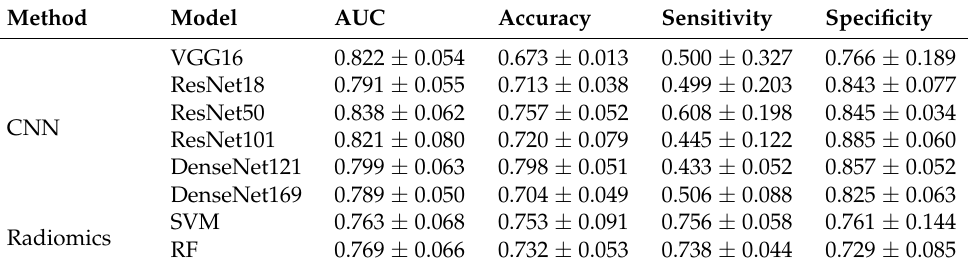
Table 2. The results of the validation of the six CNNs and two radiomic models for the classification of ACP and PCP.